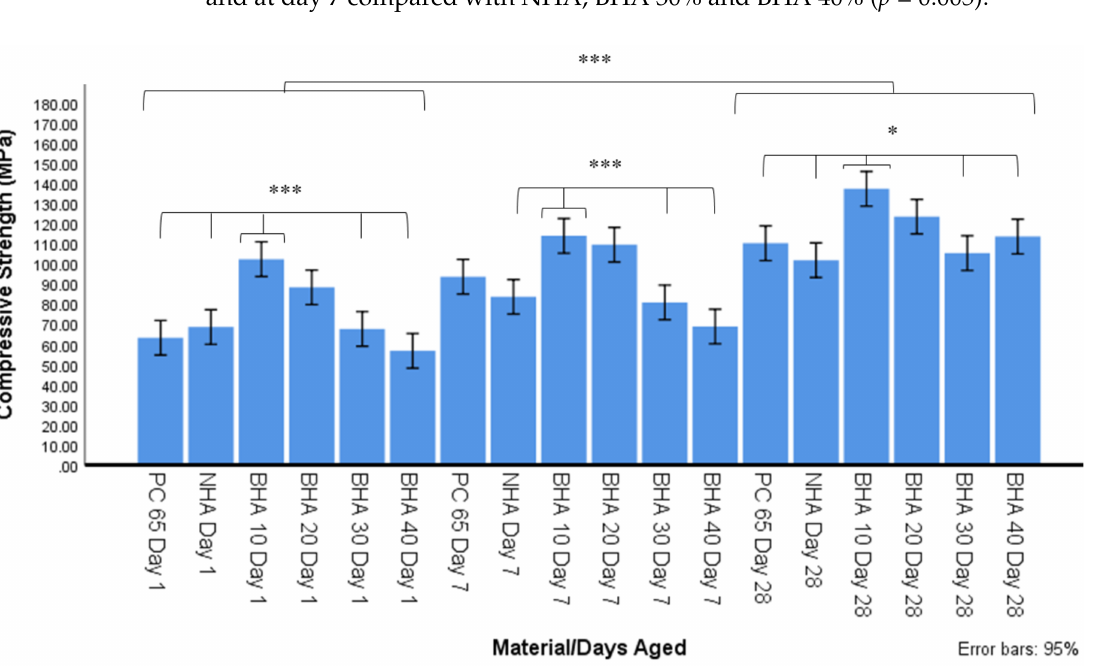
Figure 3. Compressive strength after 1, 7 and 28 days ageing in distilled water using ISO 9917-1 (2007) (n = 10). Significant differences between materials from day 1–28 ( p < 0.001), on day 1 between BHA 10% and PC 65, NHA, BHA 30% & 40% groups (*** p < 0.001), on day 7 between BHA 10% and NHA, BHA 30% and BHA 40% (*** p < 0.001), and day 28 between BHA 10 and PC65, NHA, BHA 30% and BHA 40% (* p <